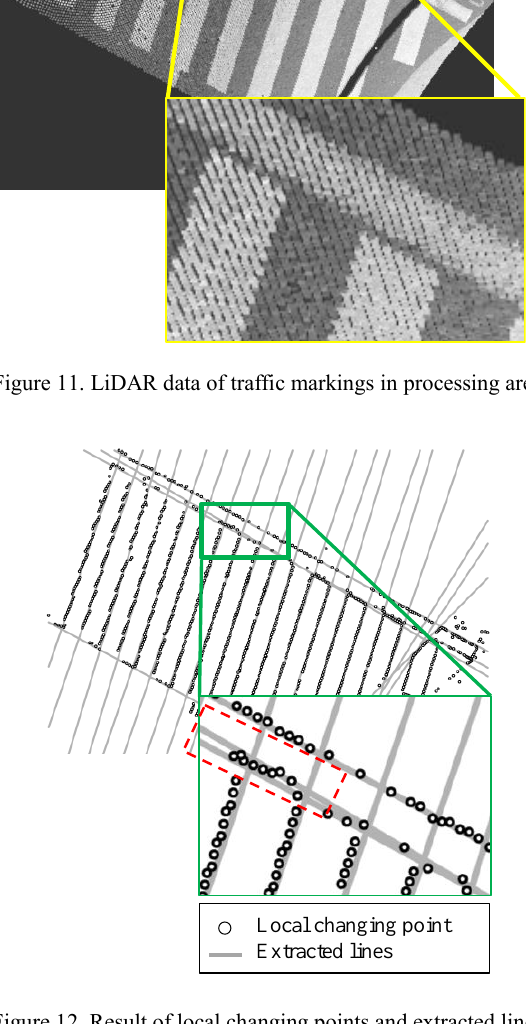
Figure 12. Result of local changing points and extracted